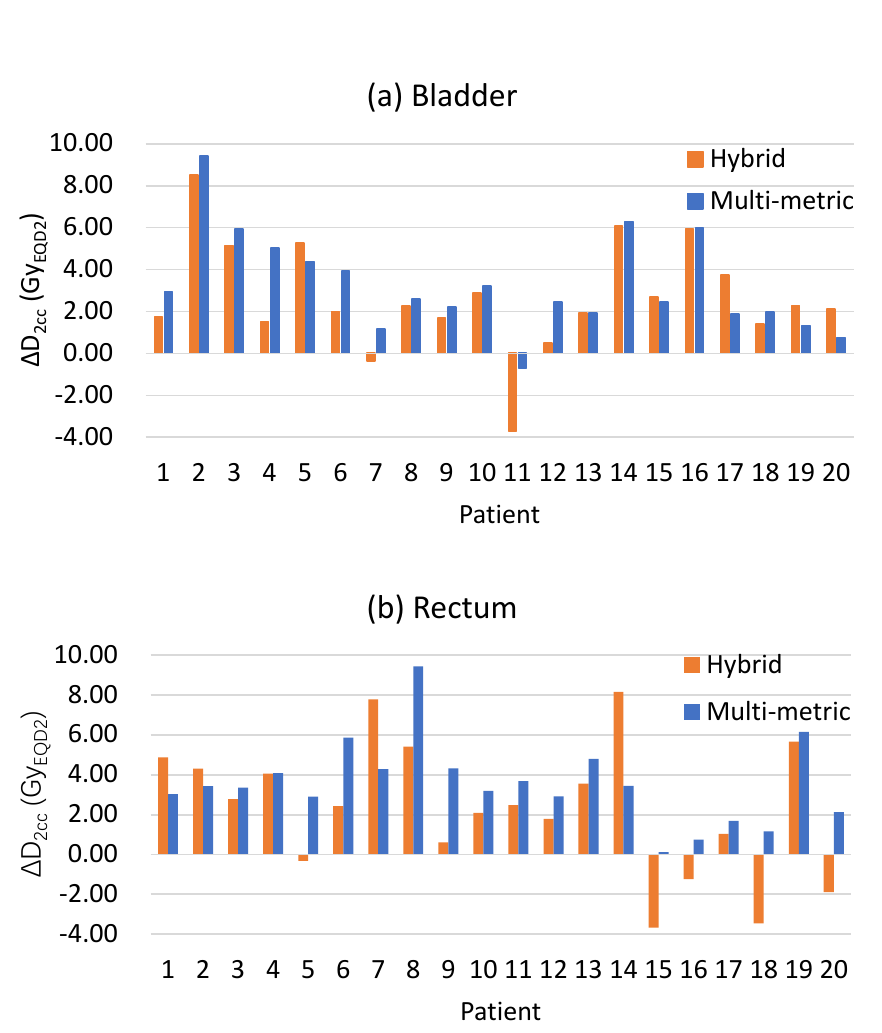
Figure 4. ∆ D 2cc of ( a ) bladder and ( b ) rectum achieved by both multi-metric and hybrid DIR methods. The orders of the patients in ( a , b ) are consistent with those in Figure 3a–d, respectively.